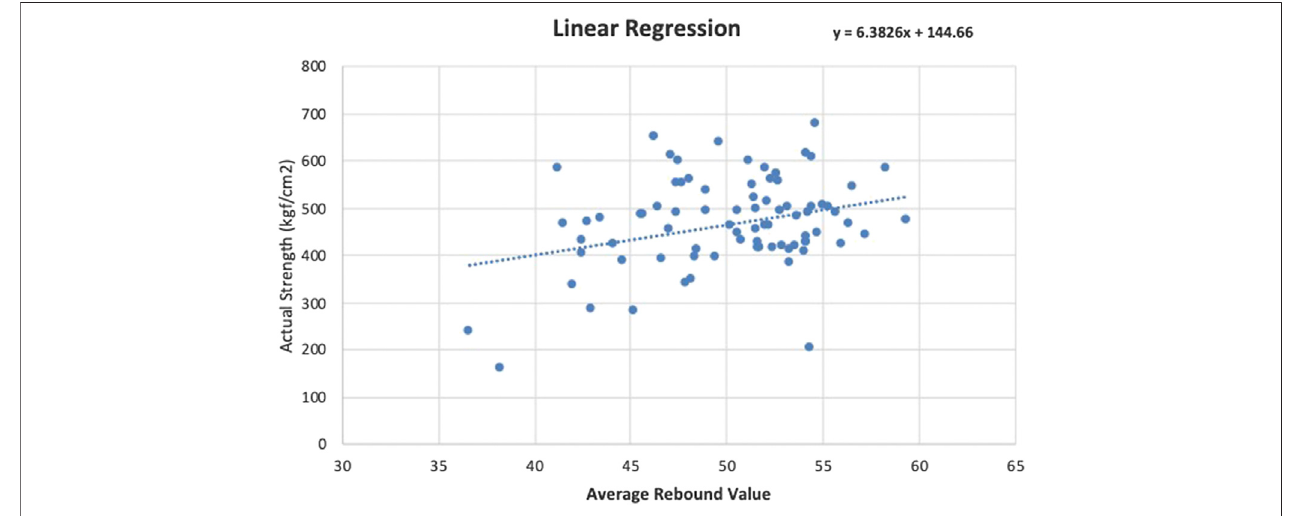
FIGURE 7 | Linear regression scatterplot.